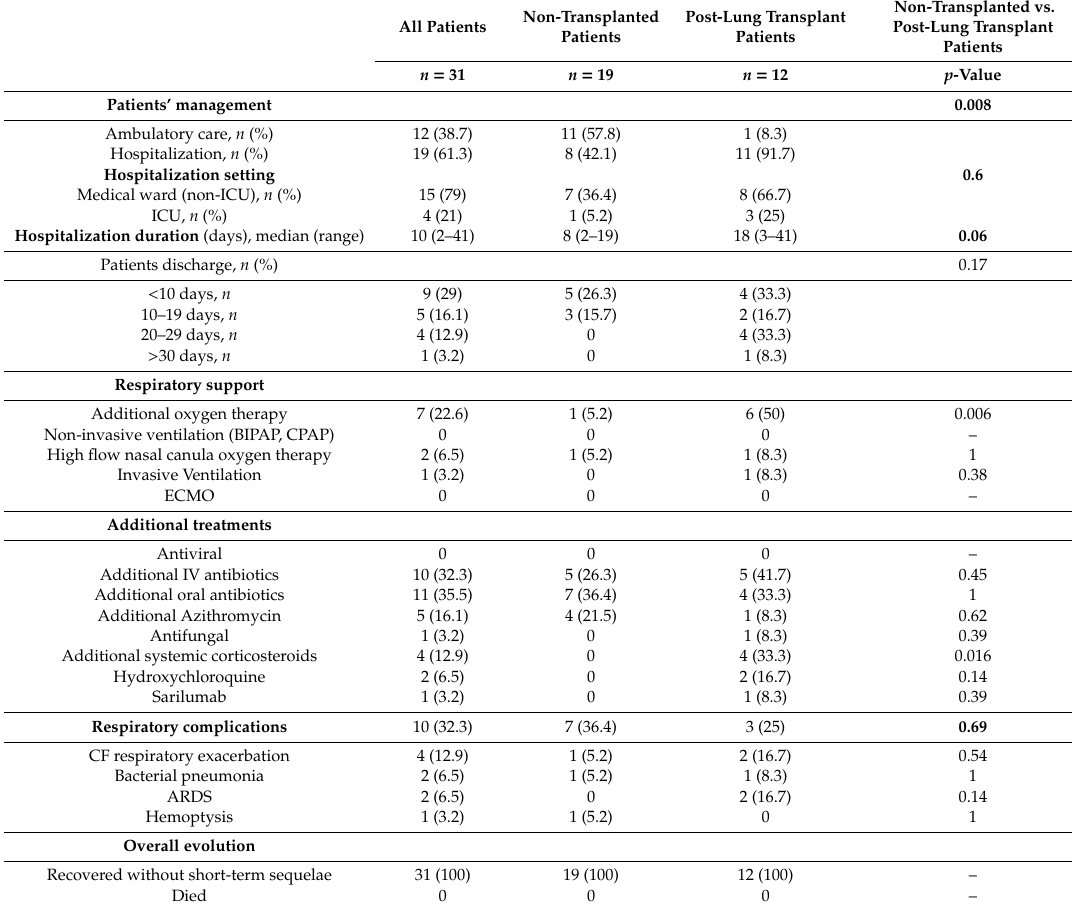
Table 2. Evolution of the 31 patients with cystic fibrosis after SARS-CoV-2